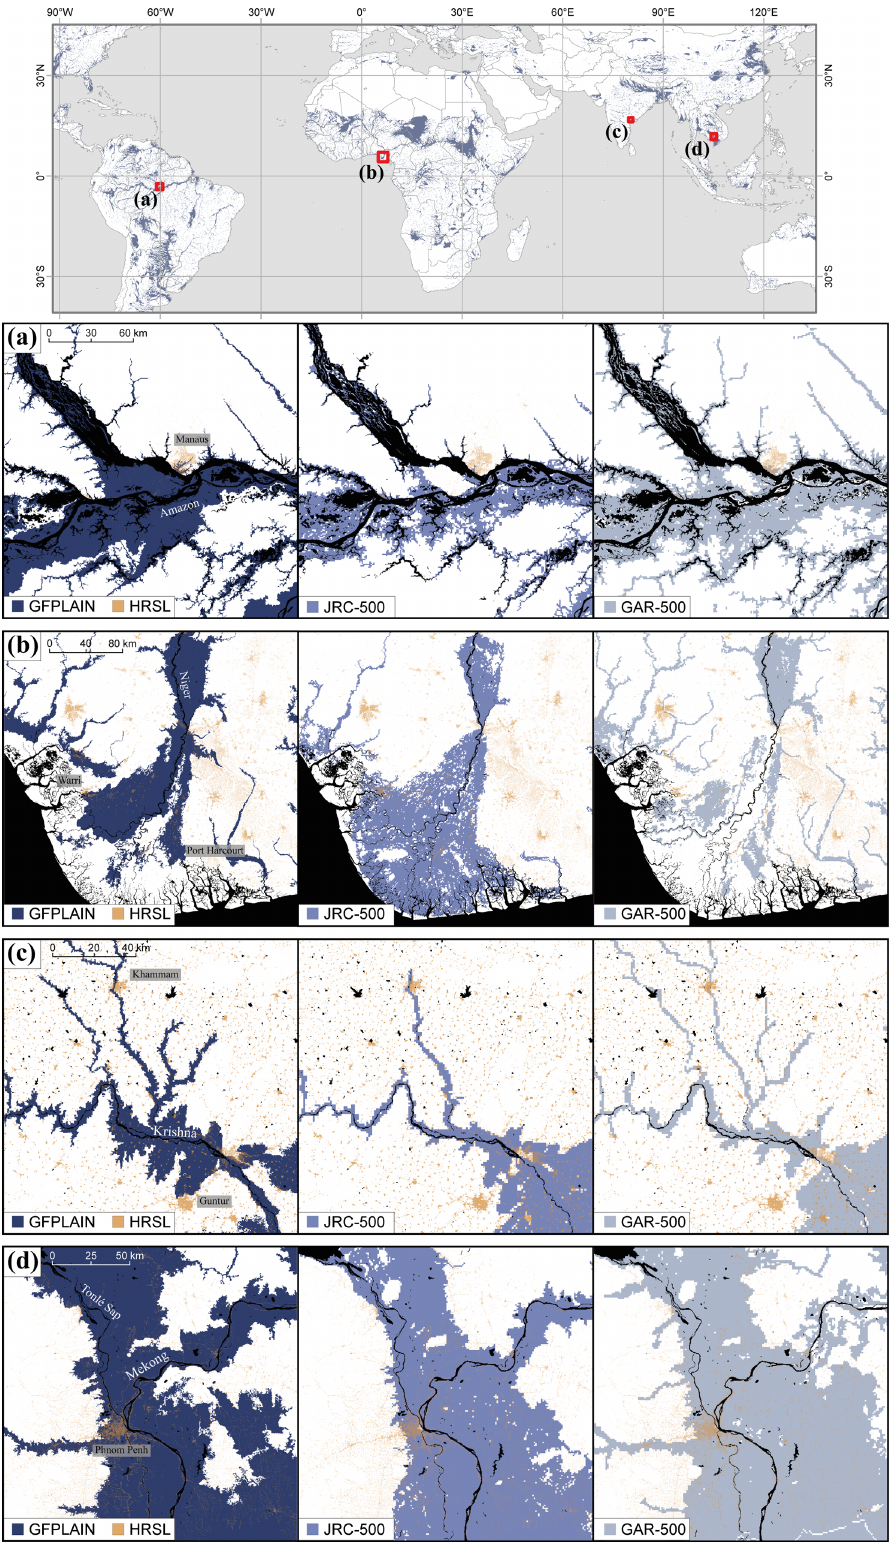
Figure 8. Spatial patterns of the hydrogeomorphic floodplain map GFPLAIN compared to the JRC and GAR flood hazard maps with a 500-year return period for the rivers (a) Amazon in Brazil, (b) Niger in Nigeria, (c) Krishna in India, and (d) the Mekong in Cambodia. The brown pixels indicate settlements mapped with the High Resolution Settlement Layer. The black pixels indicate the permanent water